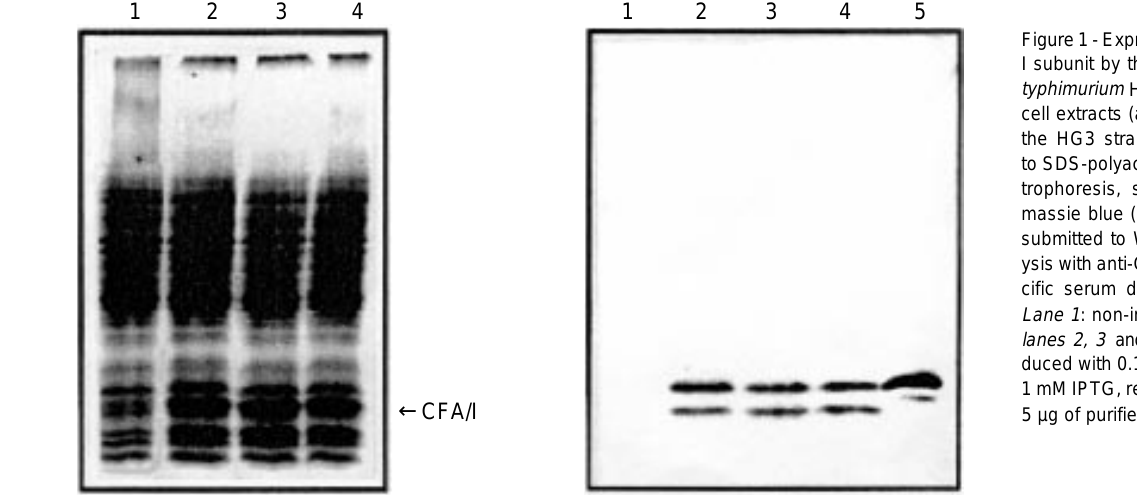
Figure 1 - Expression of the CFA/ I subunit by the recombinant S. typhimurium HG3 strain. Whole- cell extracts (about 10 7 cells) of the HG3 strain were subjected to SDS-polyacrylamide gel elec- trophoresis, stained with Coo- massie blue (20 µg/well) (A), or submitted to Western blot anal- ysis with anti-CFA/I subunit-spe- cific serum diluted 1:2000 (B). Lane 1: non-induced HG3 cells; lanes 2, 3 and 4: HG3 cells in- duced with 0.1 mM, 0.5 mM and 1 mM IPTG, respectively; lane 5: 5 µg of purified CFA/I